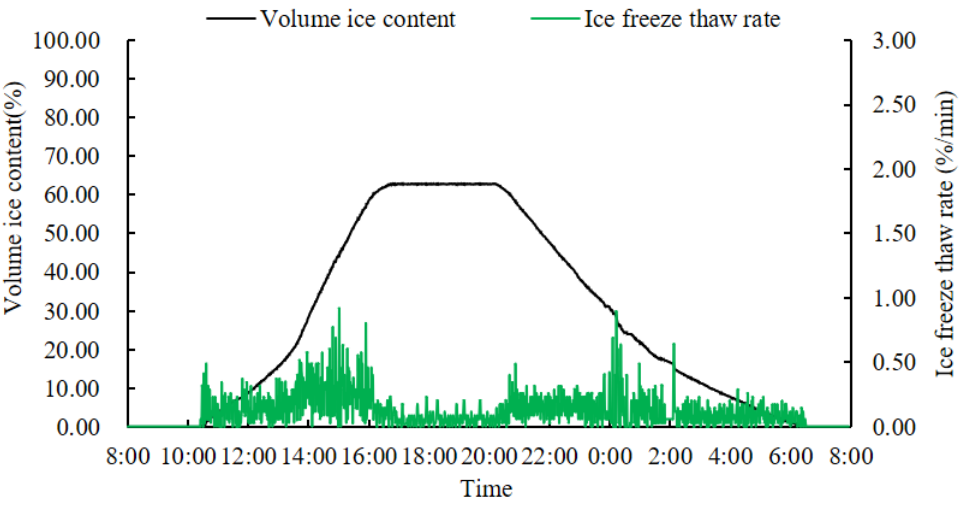
Figure 15. The variation of the branch volume ice content versus the ice freeze-thaw rate in Pachira glabra Pasq.